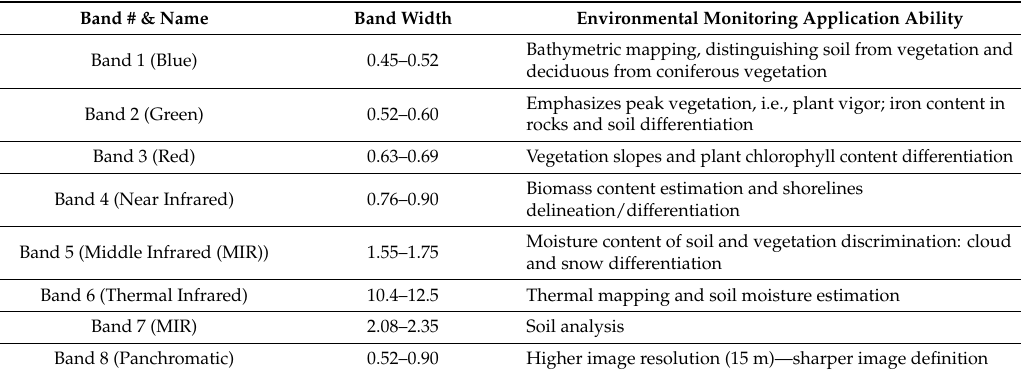
Table 1. Landsat 7 ETM+ band information and applications (adopted from [10]).